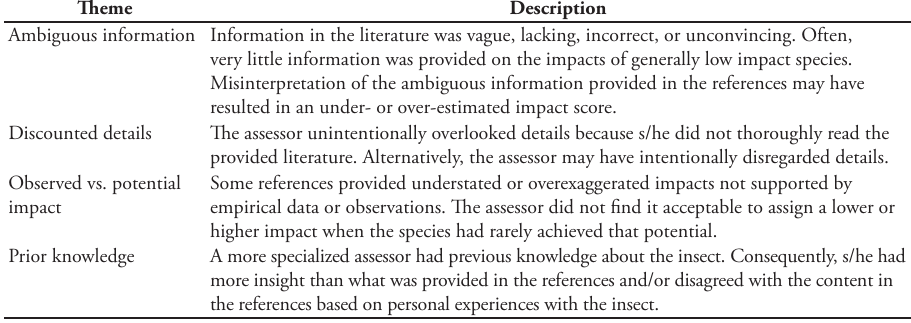
Table 2. Common themes that emerged from the joint fact-finding discussion on variation in non- native, conifer-specialist insect impact scores and reflection on problems that the assessors encountered when making their